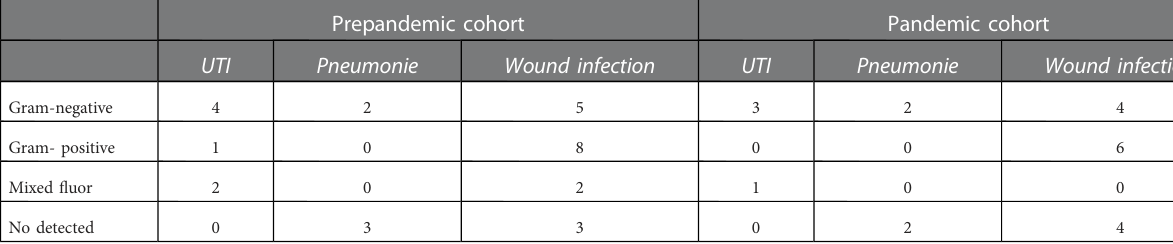
TABLE 3 Distribution of species of microorganism causing postoperative